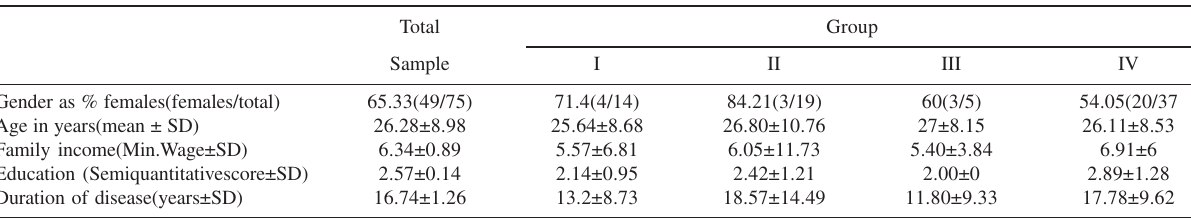
Table 1. Demographic data in AD adult patients, sorted by